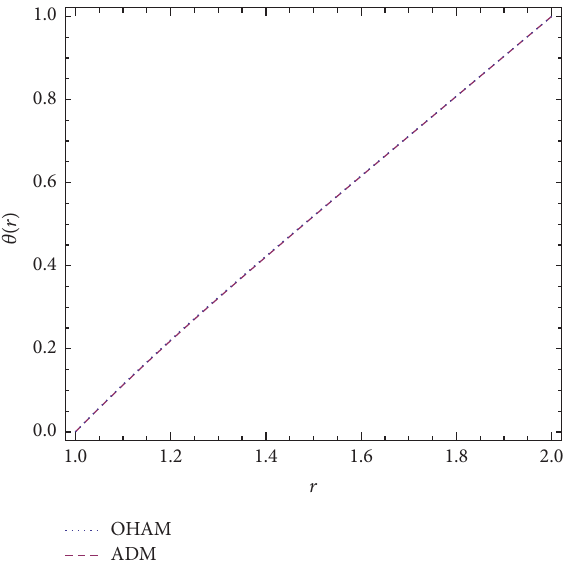
Figure 6: Temperature comparison between OHAM and ADM results when 𝛽 1 = 0.1 , 𝛽 2 = 0.5 , 𝜆 = 0.3 , 𝐵𝑟 1 = 3 , 𝐵𝑟 2 = 5 , 𝛿 = 2 , = −0.001243429 , 𝐶 𝐶 1 = 0.000294127 𝐶 4